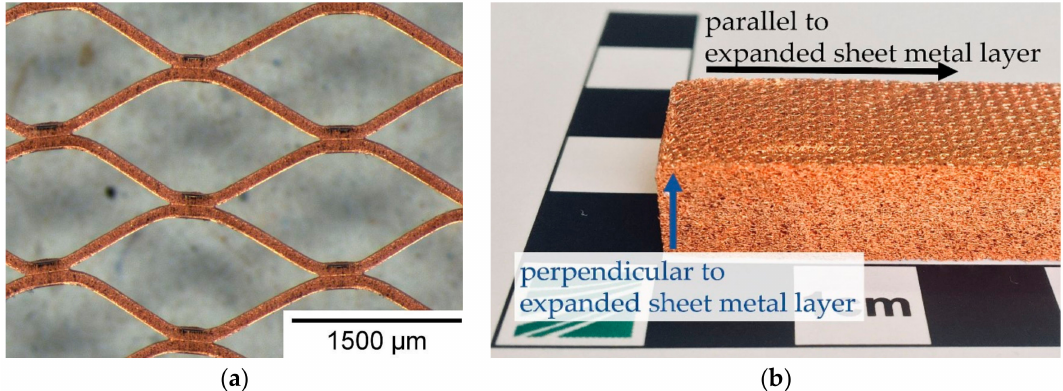
Figure 2. ( a ) Stereo microscopy image of expanded metal layer with open area of up to 80% and diamond shaped mesh for ( b ) sintered expanded sheet metal structure.